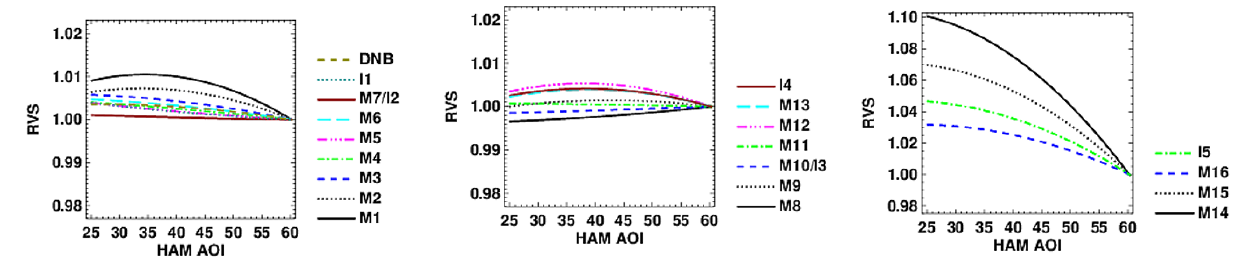
Figure 7. VIIRS RVS plotted as a function of HAM